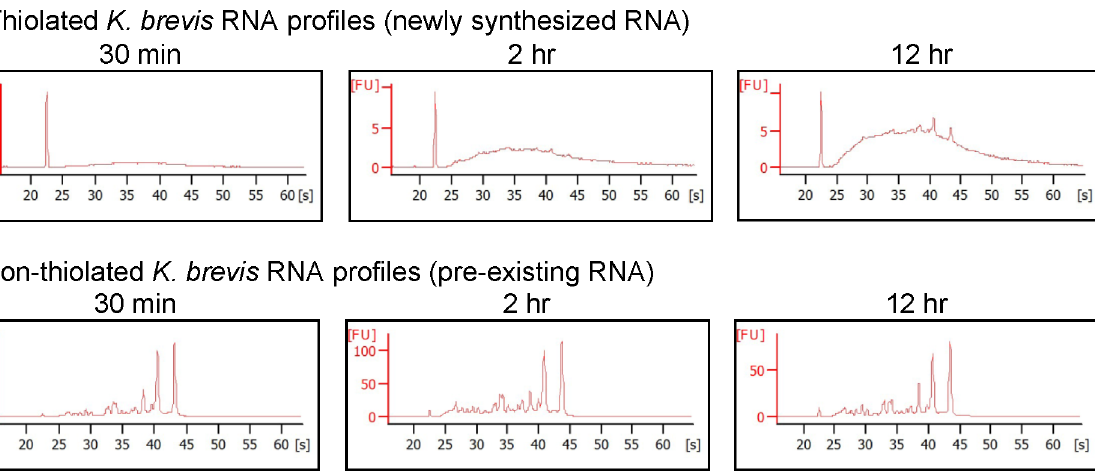
Figure 2. Representative bioanalyzer profiles of pre-existing and newly synthesized RNA fractions. A . Following 4-thiouracil (4tU) incorporation, biotinylation, and streptavidin-magnetic bead purification, newly synthesized RNA fractions are comparable to purified mRNA samples from K. brevis . With increasing labeling time, synthesis of ribosomal RNA becomes discernible, with peaks at approximately 41 and 44 s. The peak at 23 s is the manufacturer supplied internal marker (visually absent in B because of differences in the Y-axis scale). B . Bioanalyzer profiles of pre-existing RNA are similar to typical K. brevis total RNA profiles with dominant ribosomal peaks at approximately 41 and 44 s.